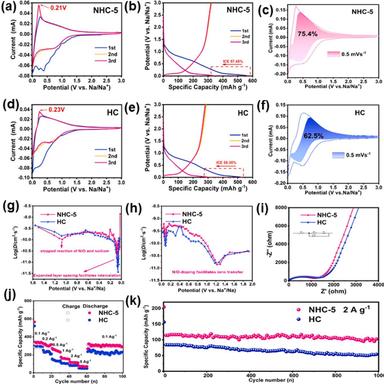
Electrochemical evaluation and kinetics analysis of the NHCs cathodes. a and d) The CV curves of NHC-5 and HC at 0.01 mV s − 1 . b and e) Charge/discharge profiles of NHC-5 and HC 0.01–3 V. c and f) Capacitive charge storage contributions at a scan rate of 0.5 mV s − 1 of NHC-5 and HC. g-h) the Na-ion diffusion coefficient as a function of the state of discharge and charge processes. i) Nyquist plots of the NHC-5 and HC. j) Rate performances of the NHC-5 and HC in the range of 0.1–5 A g− 1 . k) Long cycling